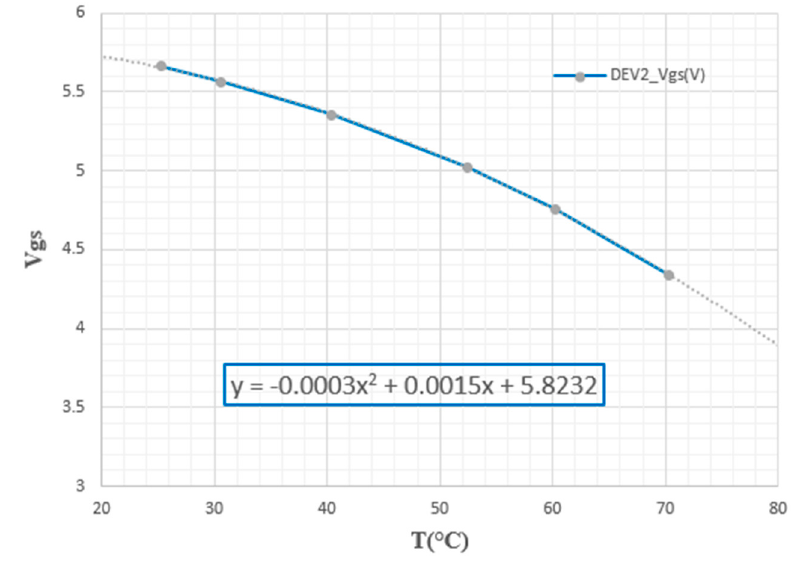
Figure 11. Calibration curve of V gs.